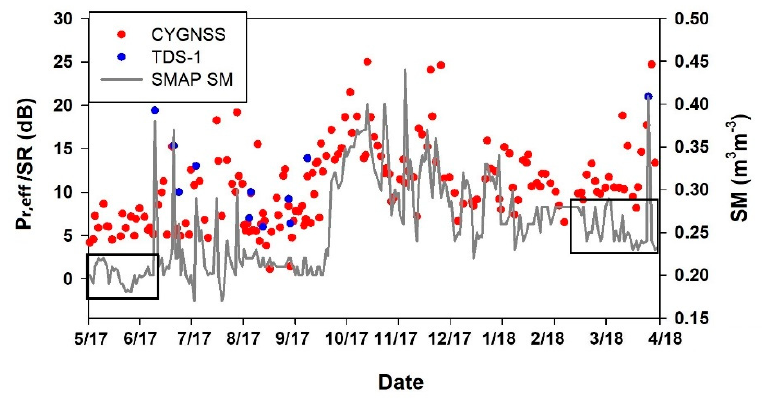
Figure 5. Variations of CYGNSS, TDS-1, and SMAP during the observation period.